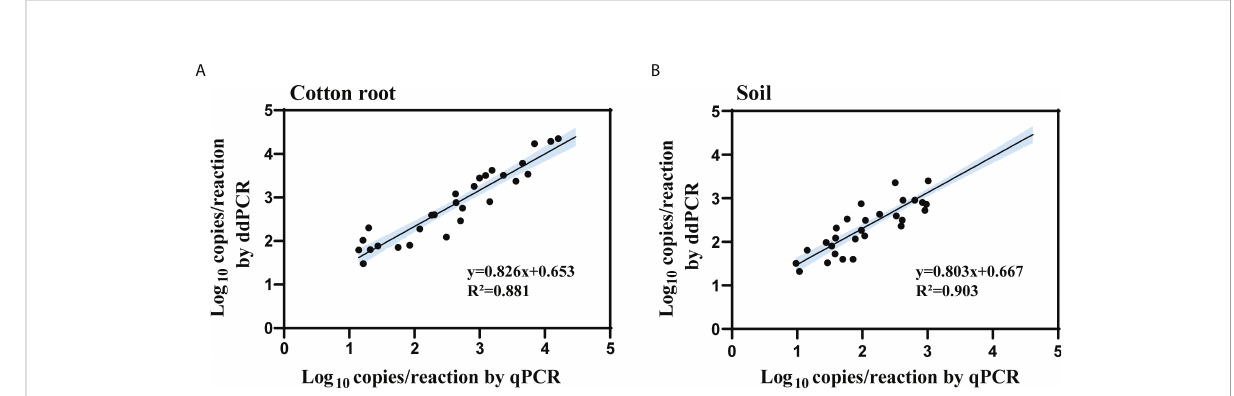
FIGURE 5 Linear regression and Pearson correlation analysis of measured copy number of the IGS target between qPCR and ddPCR for cotton root (A) and soil (B) samples. All cotton root and soil samples that tested positive by both methods were included in the analysis (cotton root samples, n = 48; soil samples, n = 30). R 2 is the proportion of variability in y that is attributable to x . Black solid line represents the correlation line; blue area represents the 95% con fi dence bands.